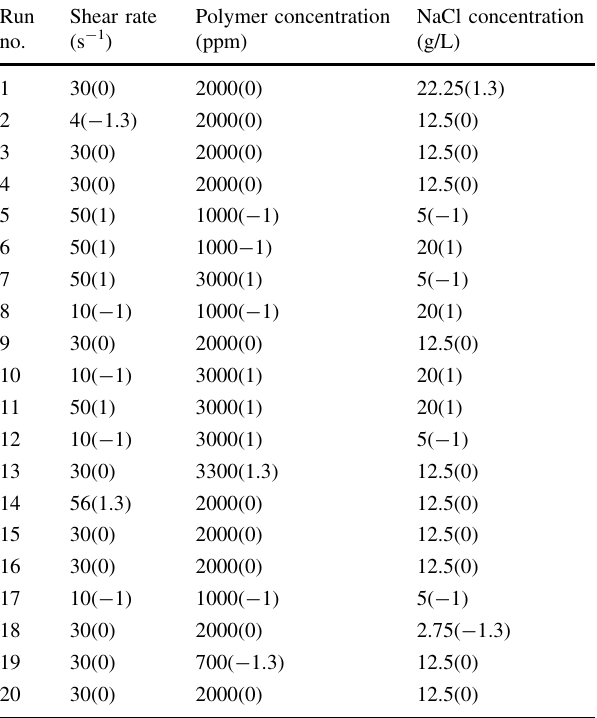
Table 1 The order and extraction conditions for the central com- posite design (CCD) including the coded levels of each parameter Run